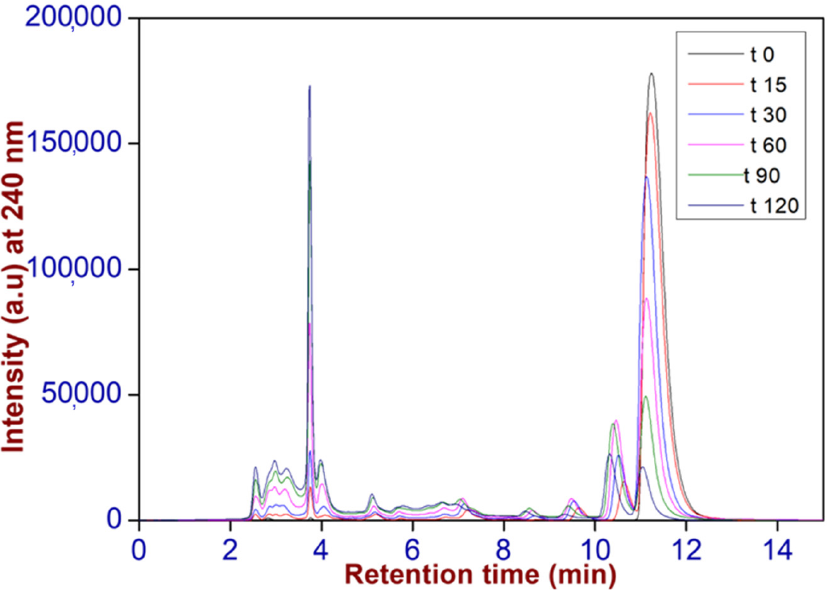
Figure 3. HPLC-UV profiles of OFL (110 mg L − 1 ) decomposition in the presence of BT under simulated solar irradiation.